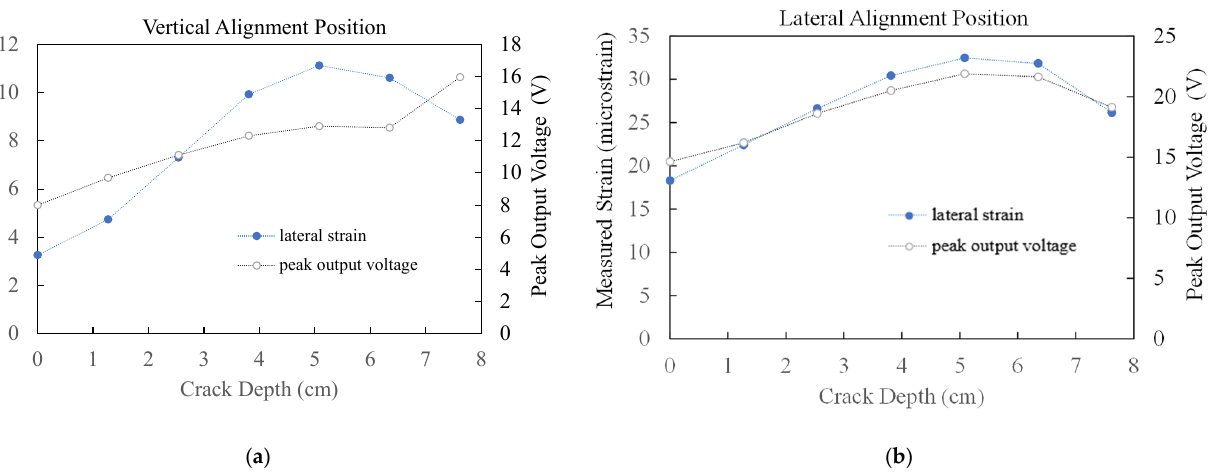
Figure 4. Measured lateral strain (along the x -axis) and peak piezoelectric-based sensor output in response to the depth of the bottom-up crack when the dynamic load moving velocity equals 25 km/h: ( a ) sensor is vertically aligned (along the y -axis); ( b ) sensor is laterally aligned (along the x -axis).